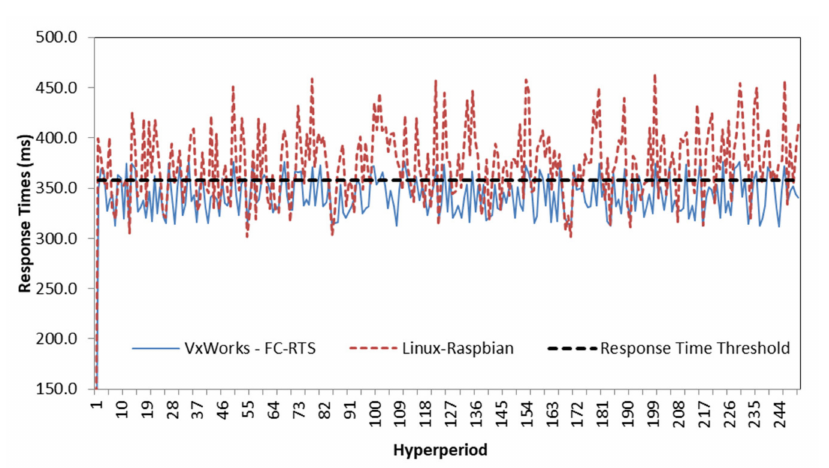
Figure 13. Response time worst